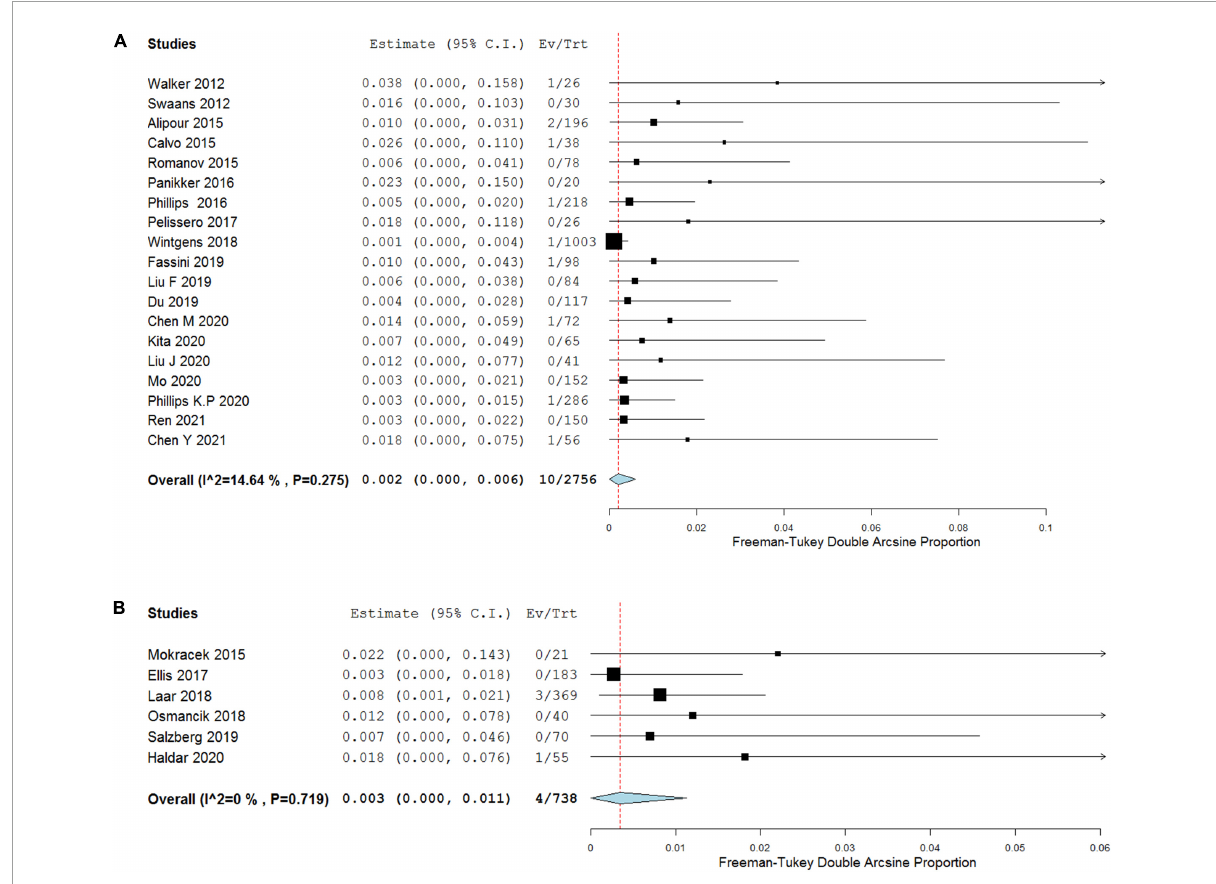
FIGURE4 Forest plots showing pooled analysis of all-cause mortality of COA (A) versus TCA (B) during follow-up